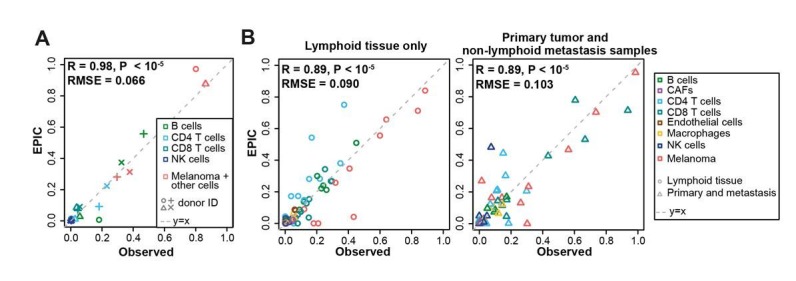
Comparison between the experimentally measured cell fractions and EPIC predictions, including additional cell types in: (A) our expanded flow cytometry analysis of melanoma; (B) lymph node metastasis and primary tumor melanoma data from Tirosh et al., 2016.